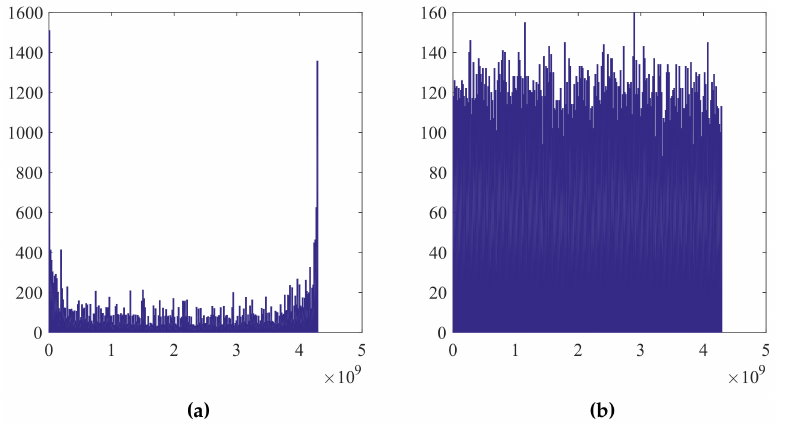
Figure 4. ( a ) Histogram of the 3D Ch; ( b ) histogram of the 3D Ch in parallel with a linear feedback shift register